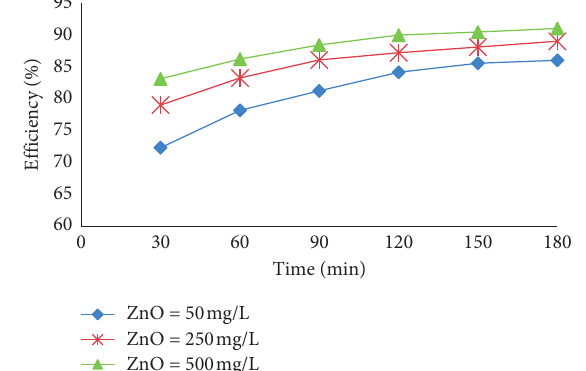
Figure 5: Effect of initial ZnO dose on degradation during treatment processes. UV: 6W; TMP: 0.5mg/L; and pH: 7.5 ±